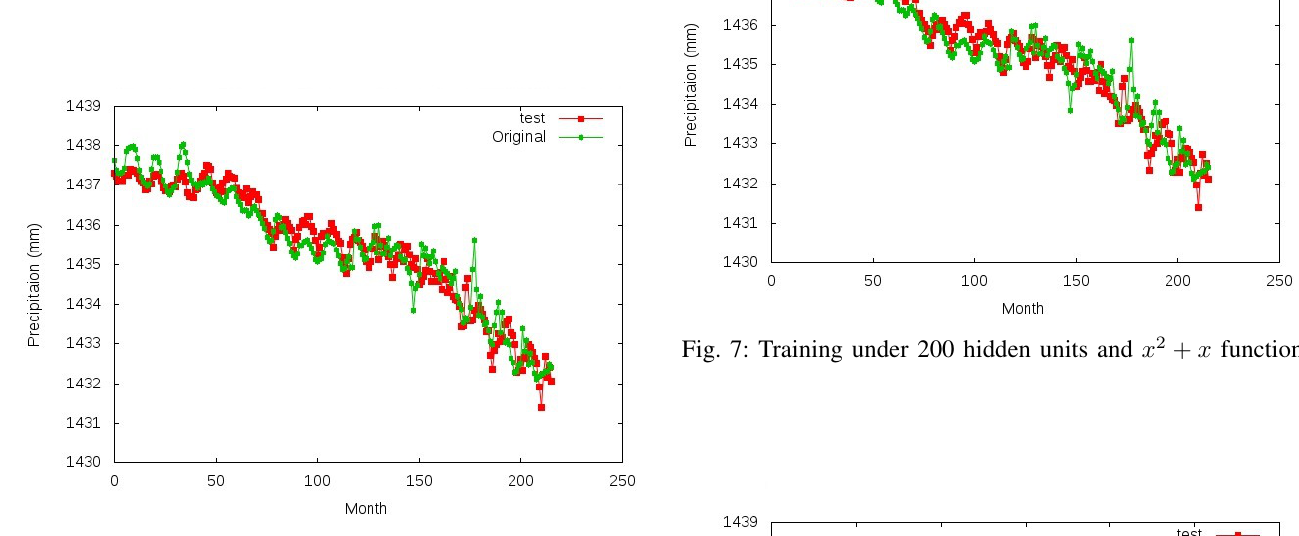
Fig. 5: Training under 200 hidden units and x 2 + x function